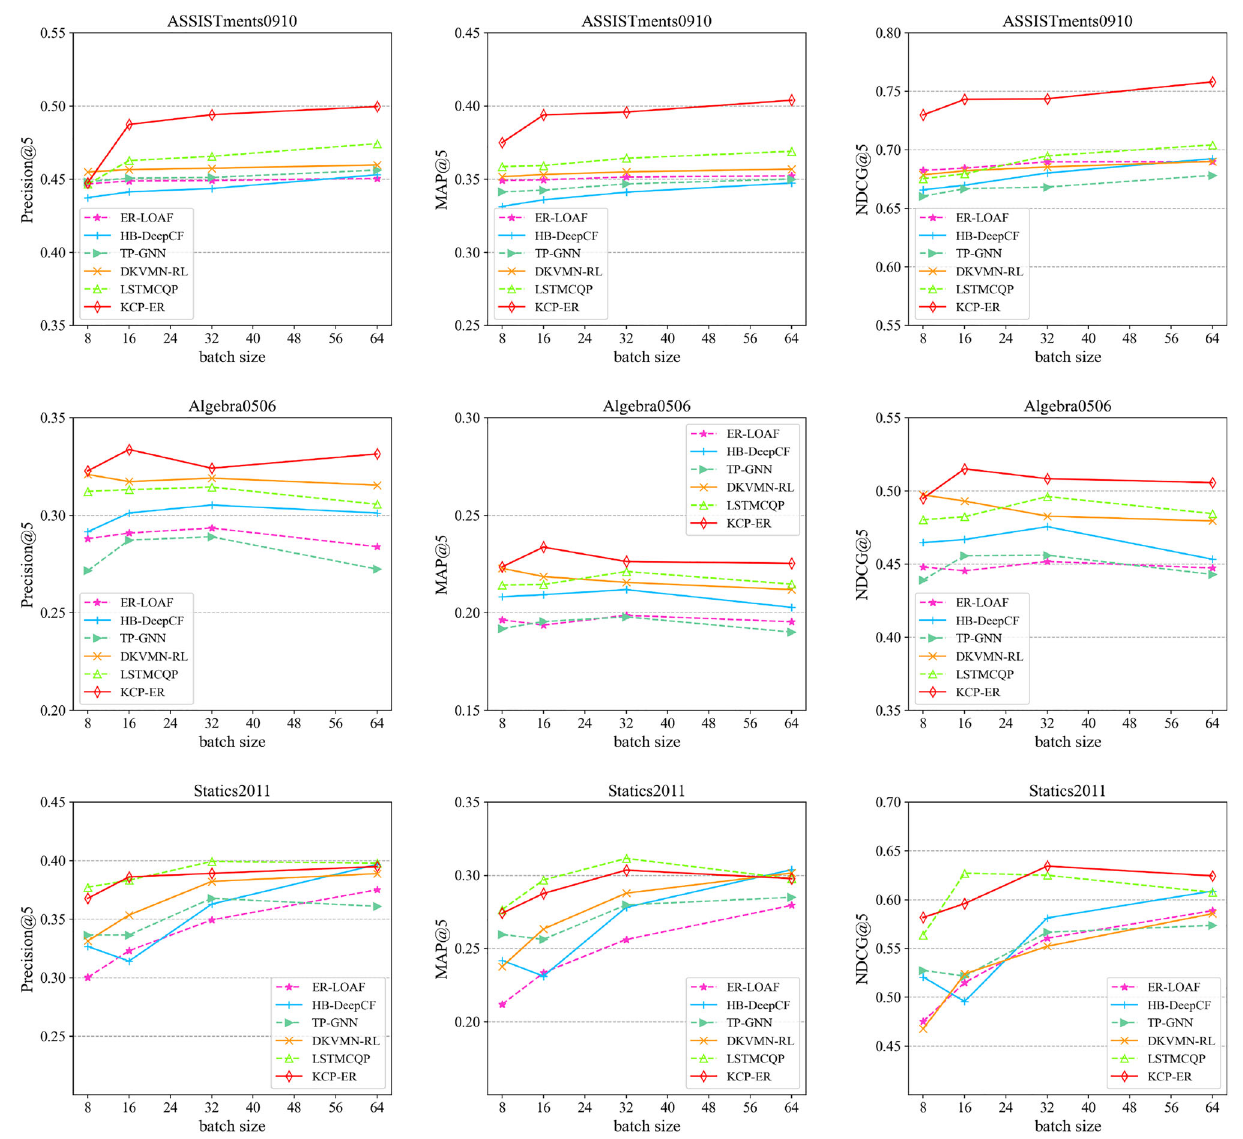
Fig. 7 Recommendation performance of TERD with batch size on three datasets